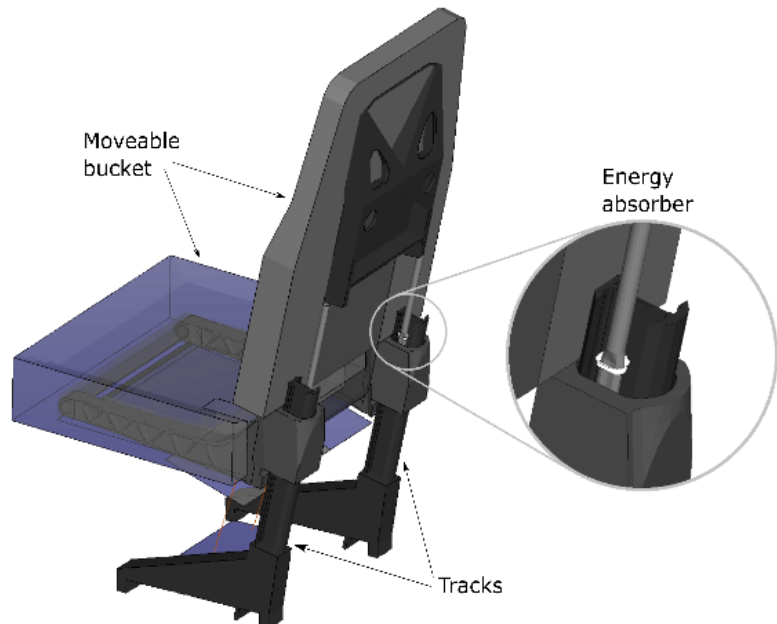
Figure 1. Typical crashworthy seat layout, with an energy absorber based on the ovalization of a thin metal tube [27].